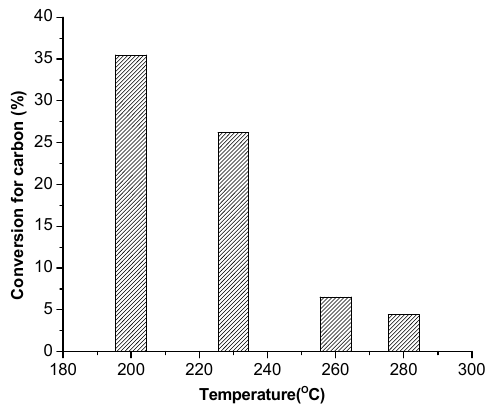
Figure 5. The conversion efficiency of carbon from biocrude obtained at different temperature (experiments on the HTC of biocrude at 200 °C, 2.0 h).